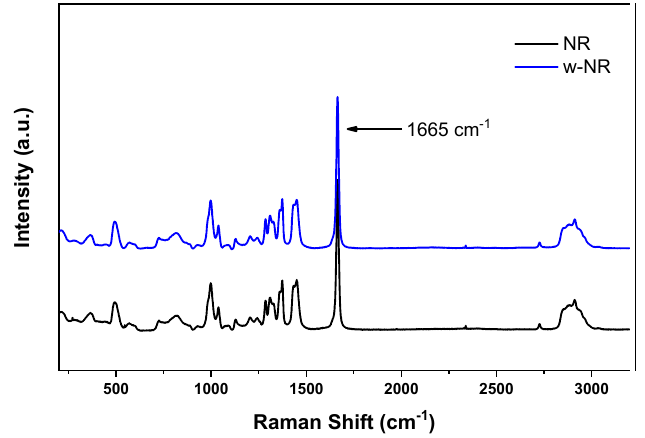
Figure 1. Raman spectra of natural rubber (NR) and washed (w)-NR.